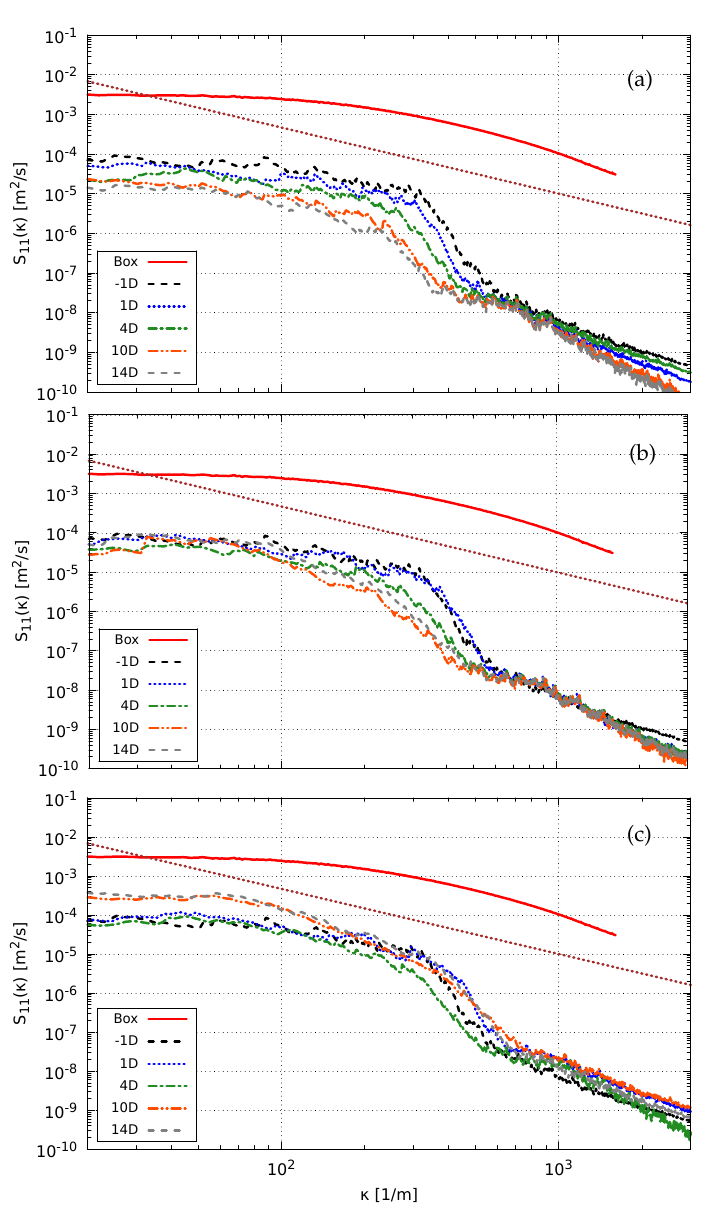
Figure 15. Longitudinal evolution of spectra at centreline using the Ti3 inflow. The results for the free decaying turbulence (without AD) are shown in the top row ( a ), results with disk C T = 0.42 are shown in the middle row ( b ) and results with disk C T = 0.62 are shown in the bottom row ( c ). The straight dotted line marks the − 5/3 slope that characterizes the inertial